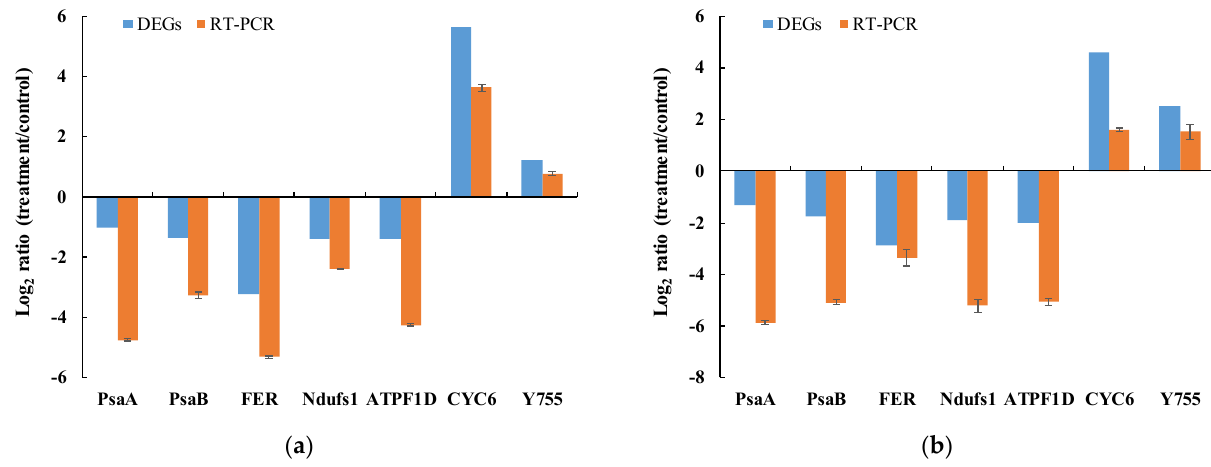
Figure 5. Comparison of the expressions of 7 differently expressed genes determined by Illumina HiSeq 2500 sequencing and qRT-PCR. ( a ) MB2 vs. CMA comparison ( b ) MB4 vs. CMA comparison.